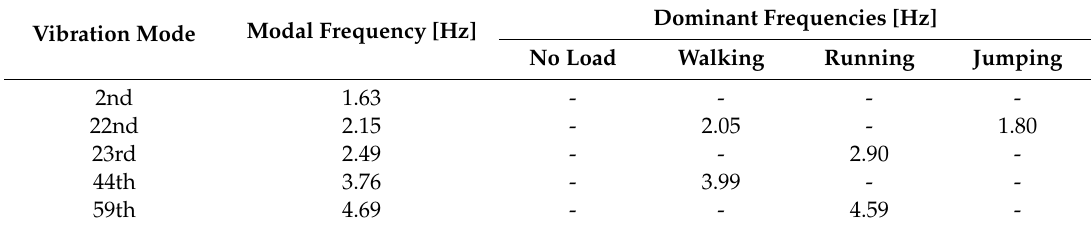
Table 4. Dominant frequencies of structural deformation identified by